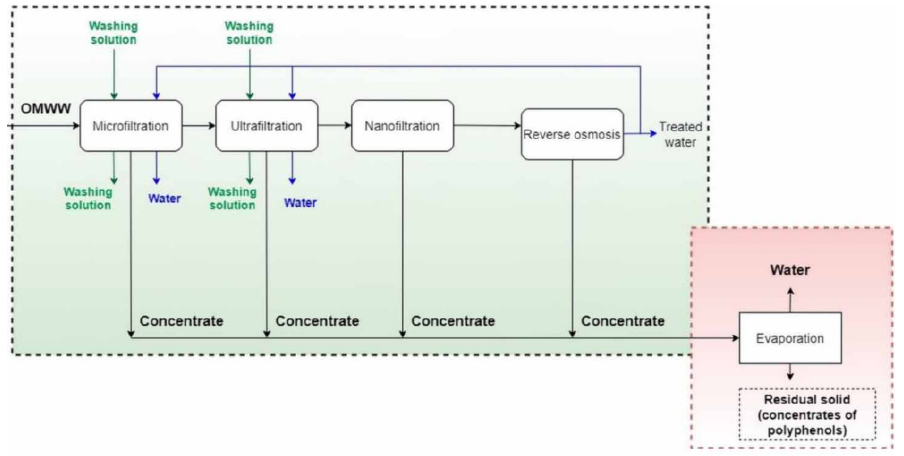
Figure 13. Treatment of OMW is free from pesticides [233].